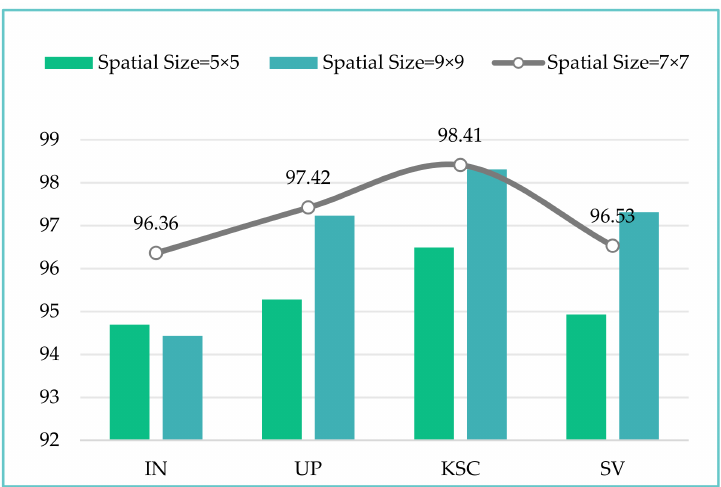
Figure 11. Overall accuracy (%) of input patches with different spatial sizes on the four